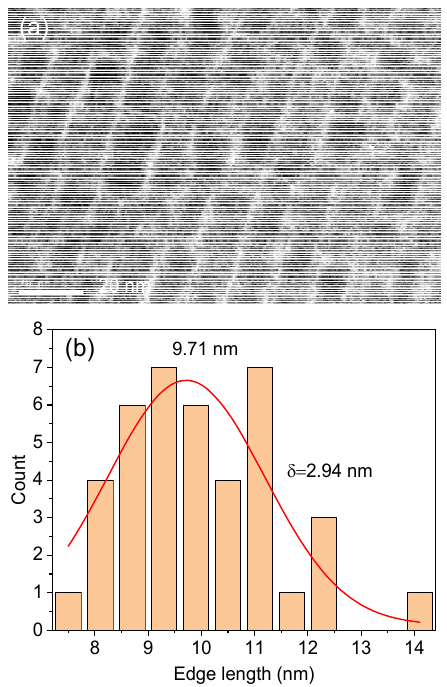
Figure 1. ( a ) TEM image of the perovskite nanocrystals (NCs) ( b ) Size distributions of the perovskite NCs calculated from the TEM image.